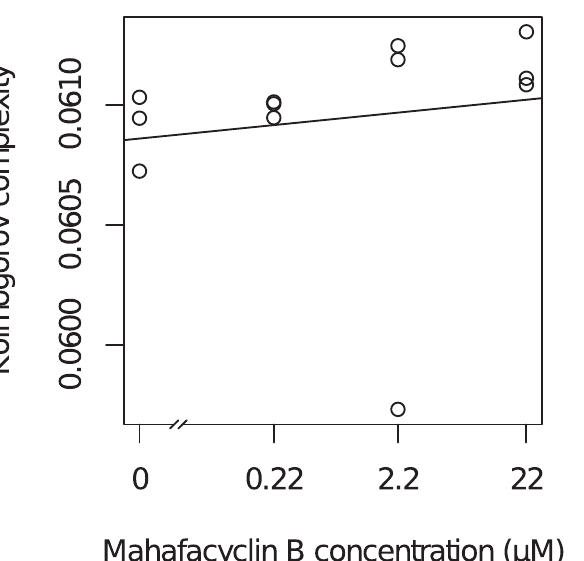
Fig 4. Comparison between transcriptomic and environmental changes in CHO-K1cells treated with mahafacyclin B. Scatter plot of drug concentration vs . Kolmogorovcomplexity representing the transcriptome of CHO-K1 cells culturedfor 10 h in DMEM/F12 mediumsupplemented with mahafacyclinB.